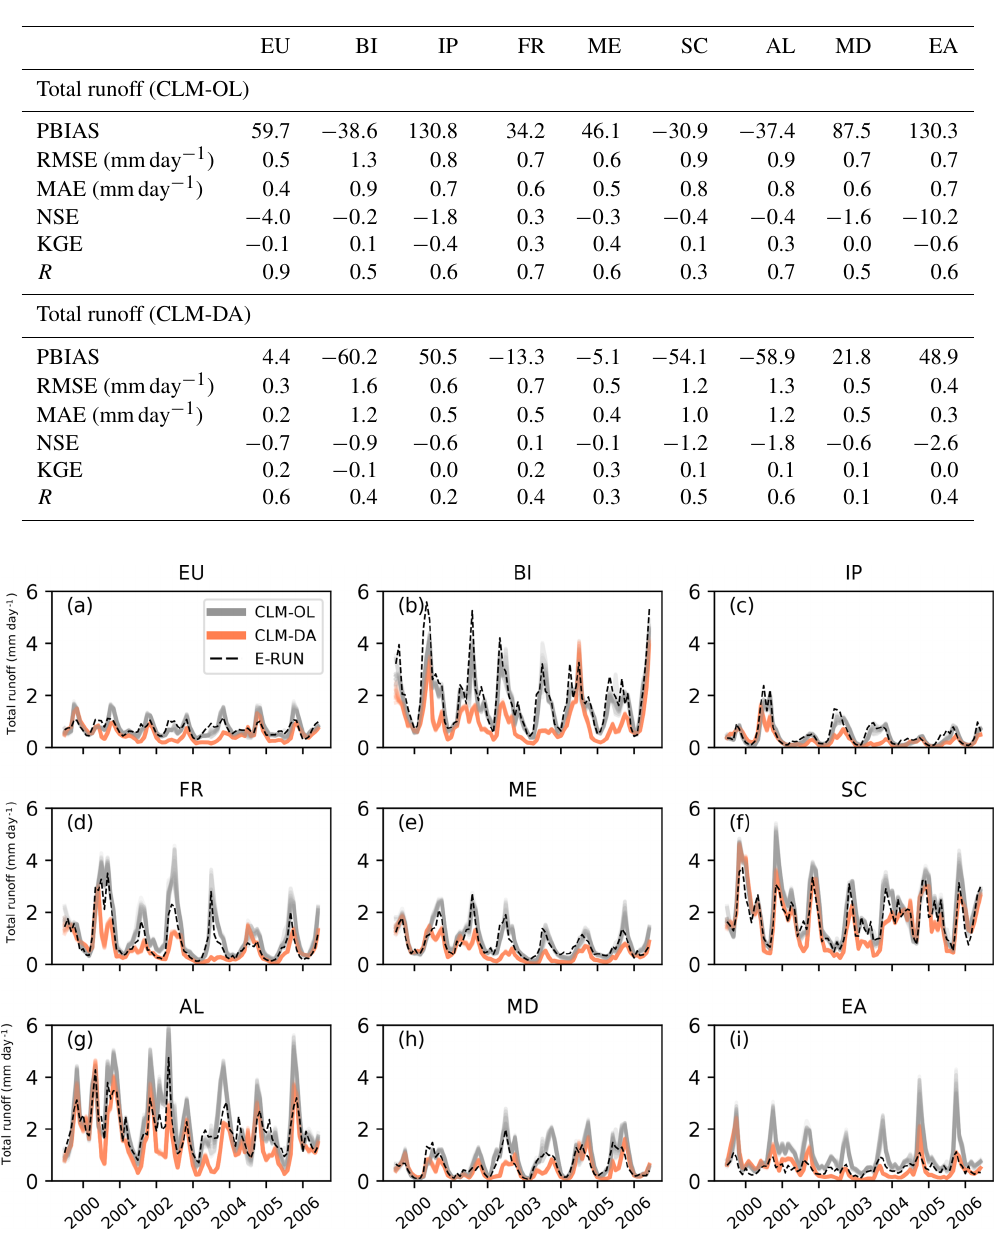
Table 4. Evaluation performance criteria for comparing CLM-OL and CLM-DA with E-RUN (spatially averaged runoff, EU and PRU- DENCE regions).